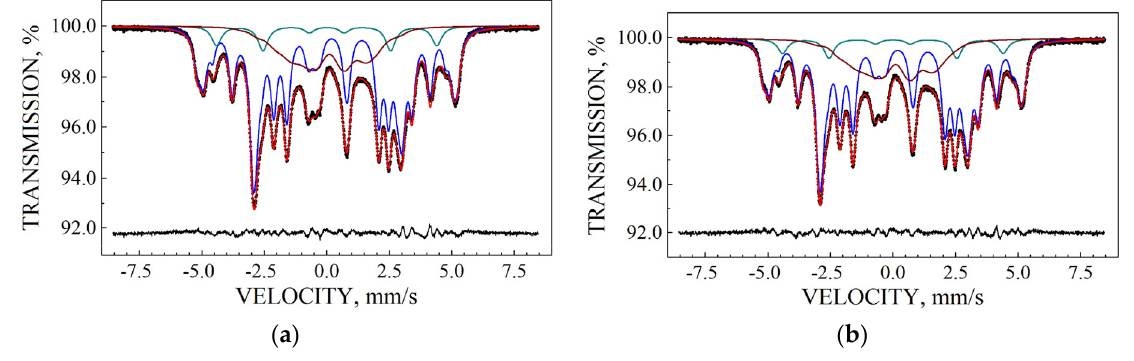
Figure 78. Room temperature Mössbauer spectra of FINEMET ribbons with different permeabilities: F1, μ r = 34,500 ( a ) and F2, μ r = 190,000 ( b ). The Mössbauer spectra were measured in 4096 channels and converted into 2048 ‐ channel spectra. The spectra were fitted by the model described in detail in [100]. The differential spectra are shown on the bottom. Adapted from Ref. [102] with permission from Elsevier: Materials Chemistry and Physics, Vol. 180, Oshtrakh M.I., Klencsar Z., Semionkin